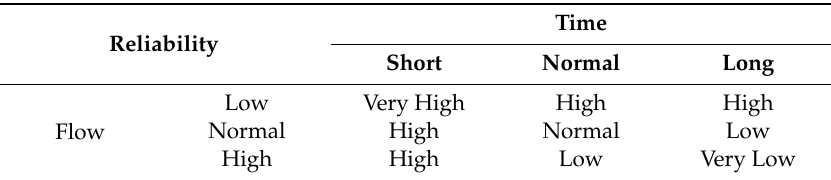
Table 13. Fuzzy rule library.